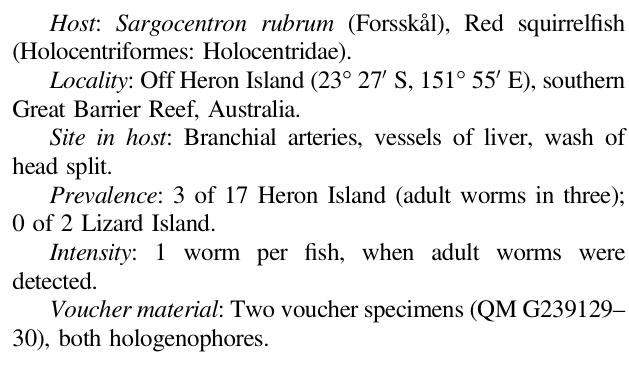
Representative DNA sequences : Partial cox 1 mtDNA, three